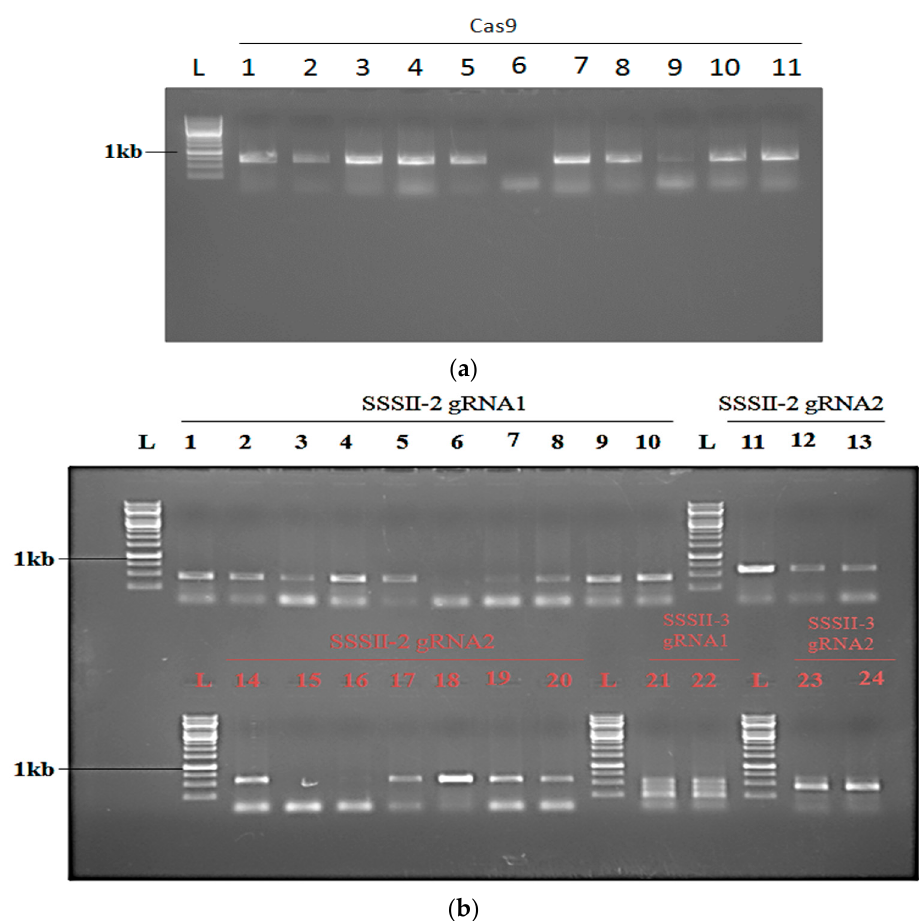
Figure 5. The confirmation of transgenic plant lines in the laboratory using the PCR technique employing isolated DNA from mutant plants of PB1509 and control plants. L band is 1 kb DNA ladder. ( a ) The confirmation of bands 1 to 11 of Cas9 were PCR-confirmed with Cas9 primers of SSSII-2 genes. ( b ) Bands 1 to 10 of SSSII-2 gRNA1 were confirmed with SSSII-2 target 1 sequence primers, bands 11 to 20 of SSSII-2 gRNA2 were PCR-confirmed by SSSII-2 target 2 primers, and bands 21 and 22 of SSSII-3 gRNA1 and bands 23 and 24 of SSSII-3 gRNA2 were confirmed with their respective targeted sequence primers.